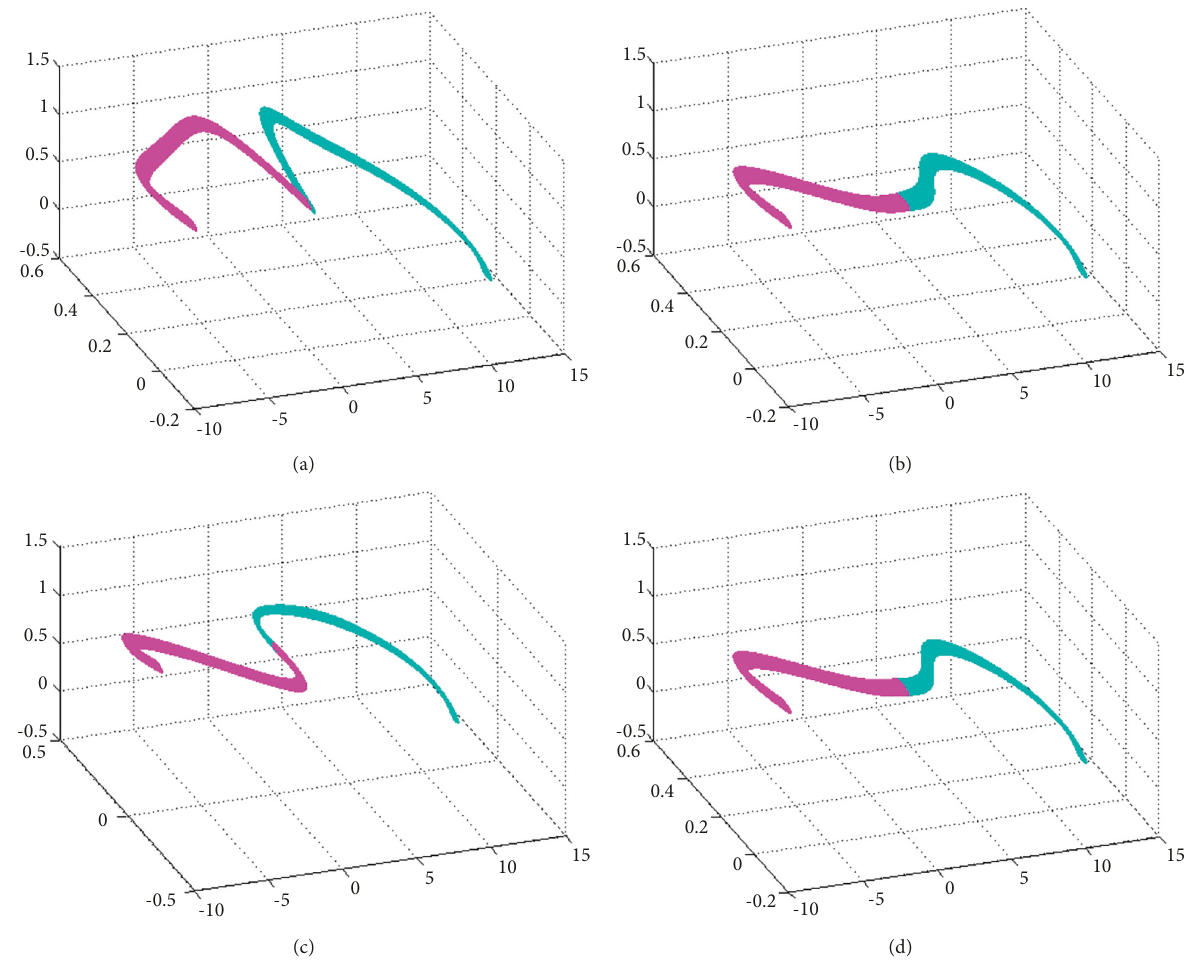
Figure 5: Smoothing two connected BBCs from C 0 to C 1 by minimizing the combined energy. (a) C 0 connection. (b) C 1 connection ( k 2). (d) C 1 connection ( k (c) C 1 connection ( k (cid:29) (cid:29)